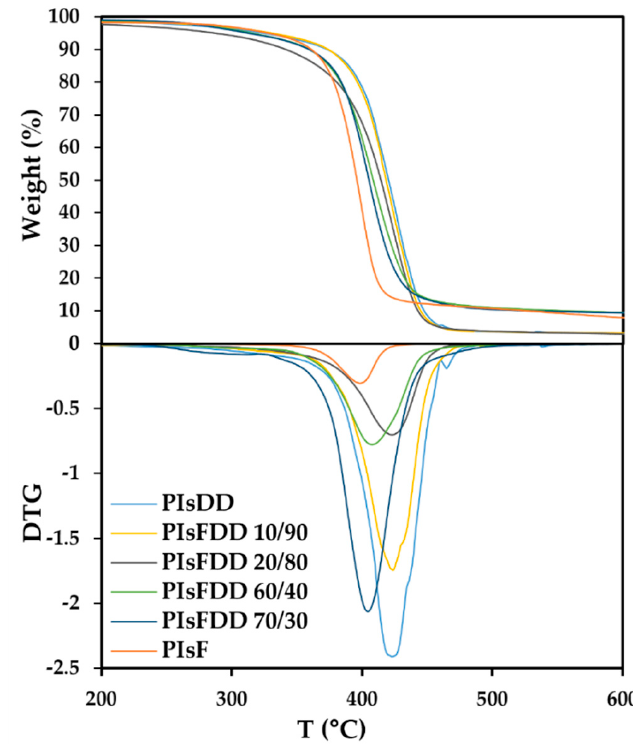
Figure 4. TGA and DTG thermograms of PIsFDDs and corresponding homopolyesters.